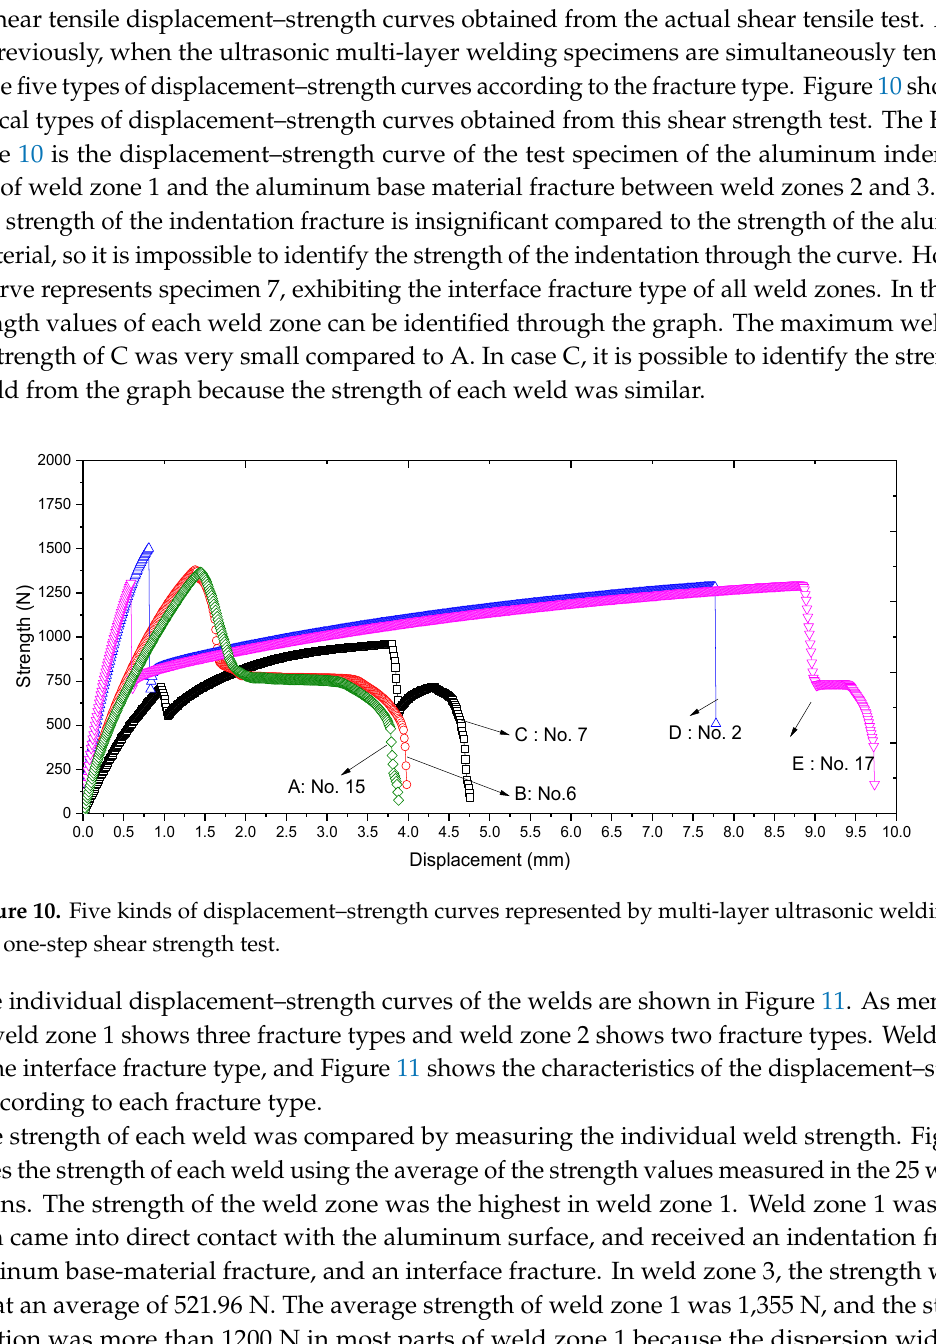
Figure 11. Six kinds of displacement–strength curves represented by multi-layer ultrasonic welding in a multi-step shear strength test.